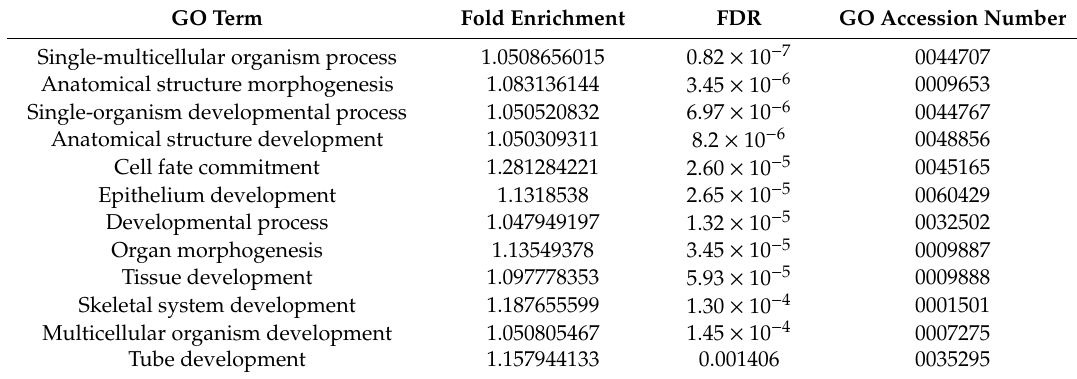
Table 4. Gene ontology (GO) analysis of di ff erentially methylated probes to pool together for signature sets.